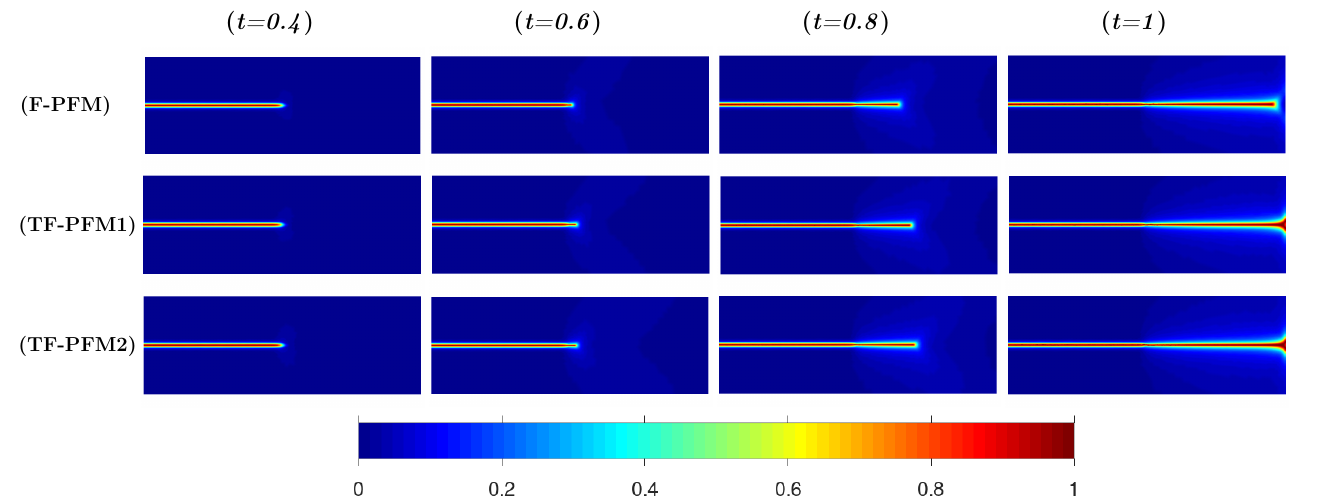
Figure 10. Snapshots of crack propagation with F-PFM, TF-PFM1, and TF-PFM2 in ( − 1,1 ) × ( − 0.35,0.35 ) at t = 0.4, 0.6, 0.8, 1 (left to right). For TF-PFM1 and TF-PFM2, we use the thermoelasticity coupling parameter δ = 0.5, and the color represents the value of z .